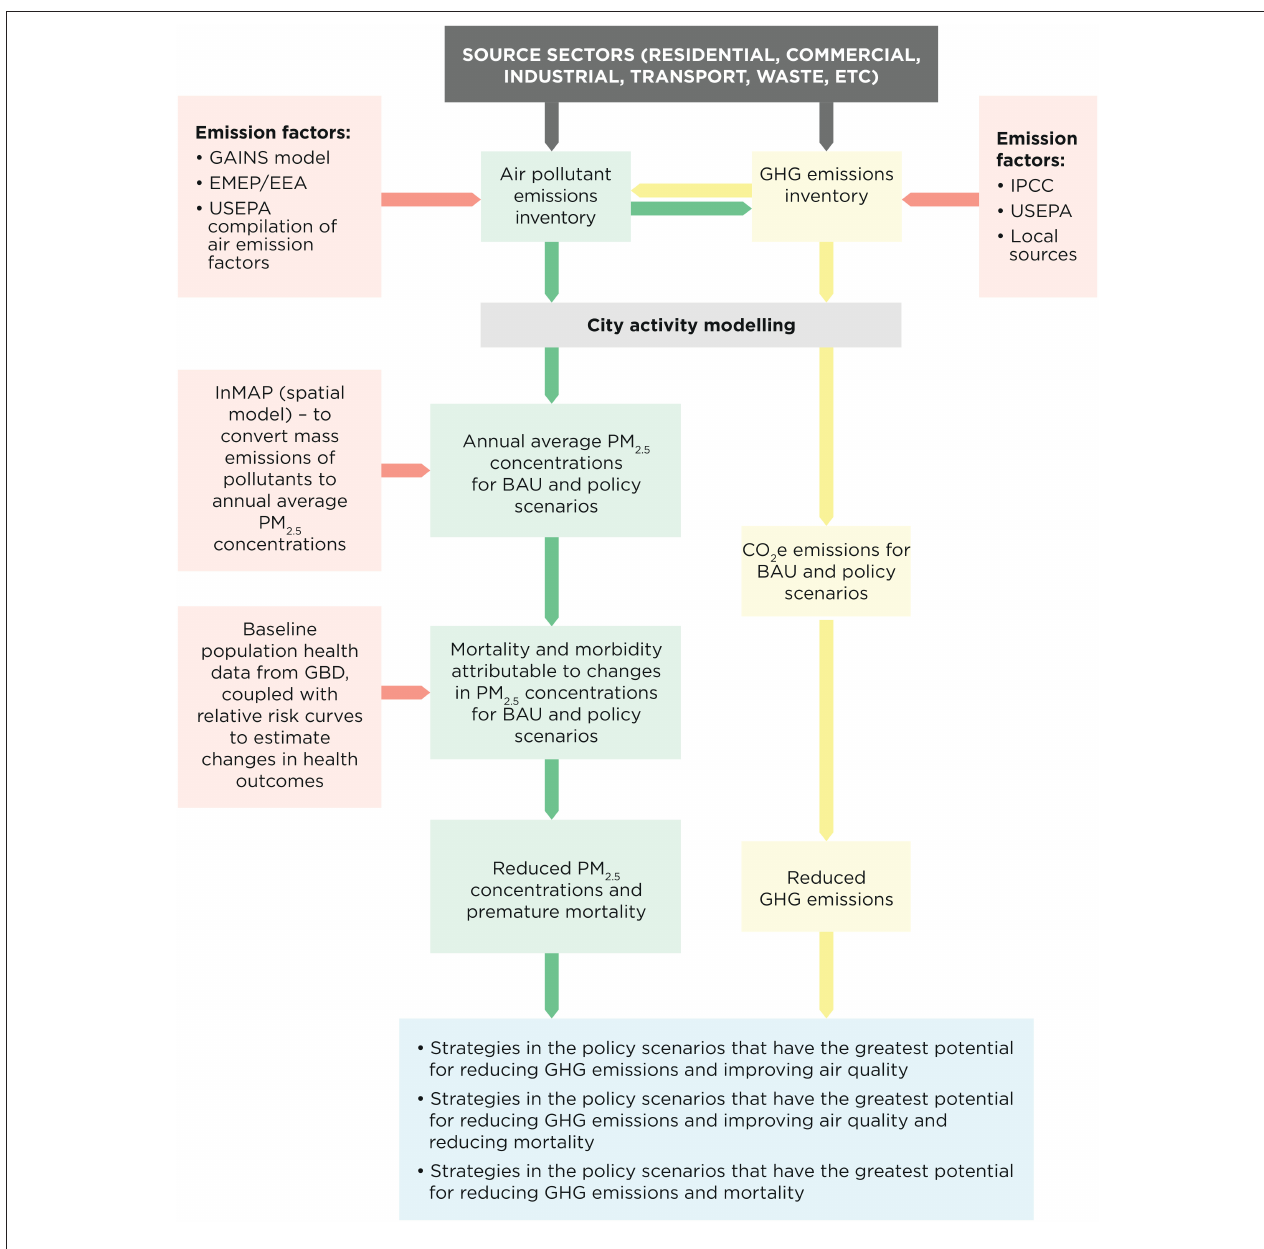
FIGURE 3 | Flow diagram and model structure of C40’s Pathways-AQ